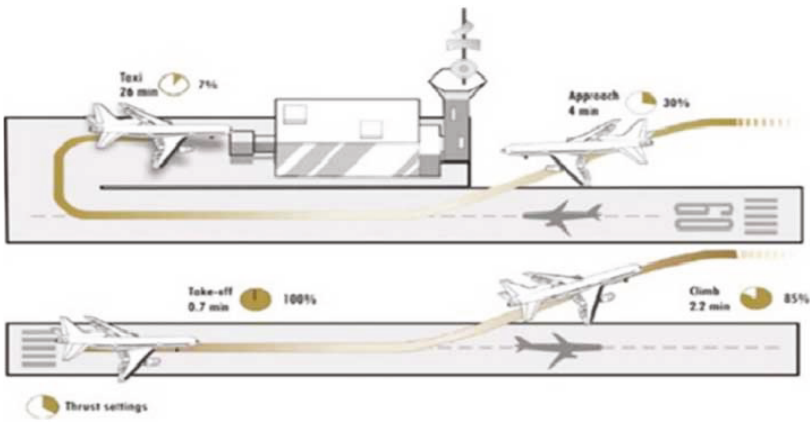
Figure 2: Phase of fl ight of an aircraft.